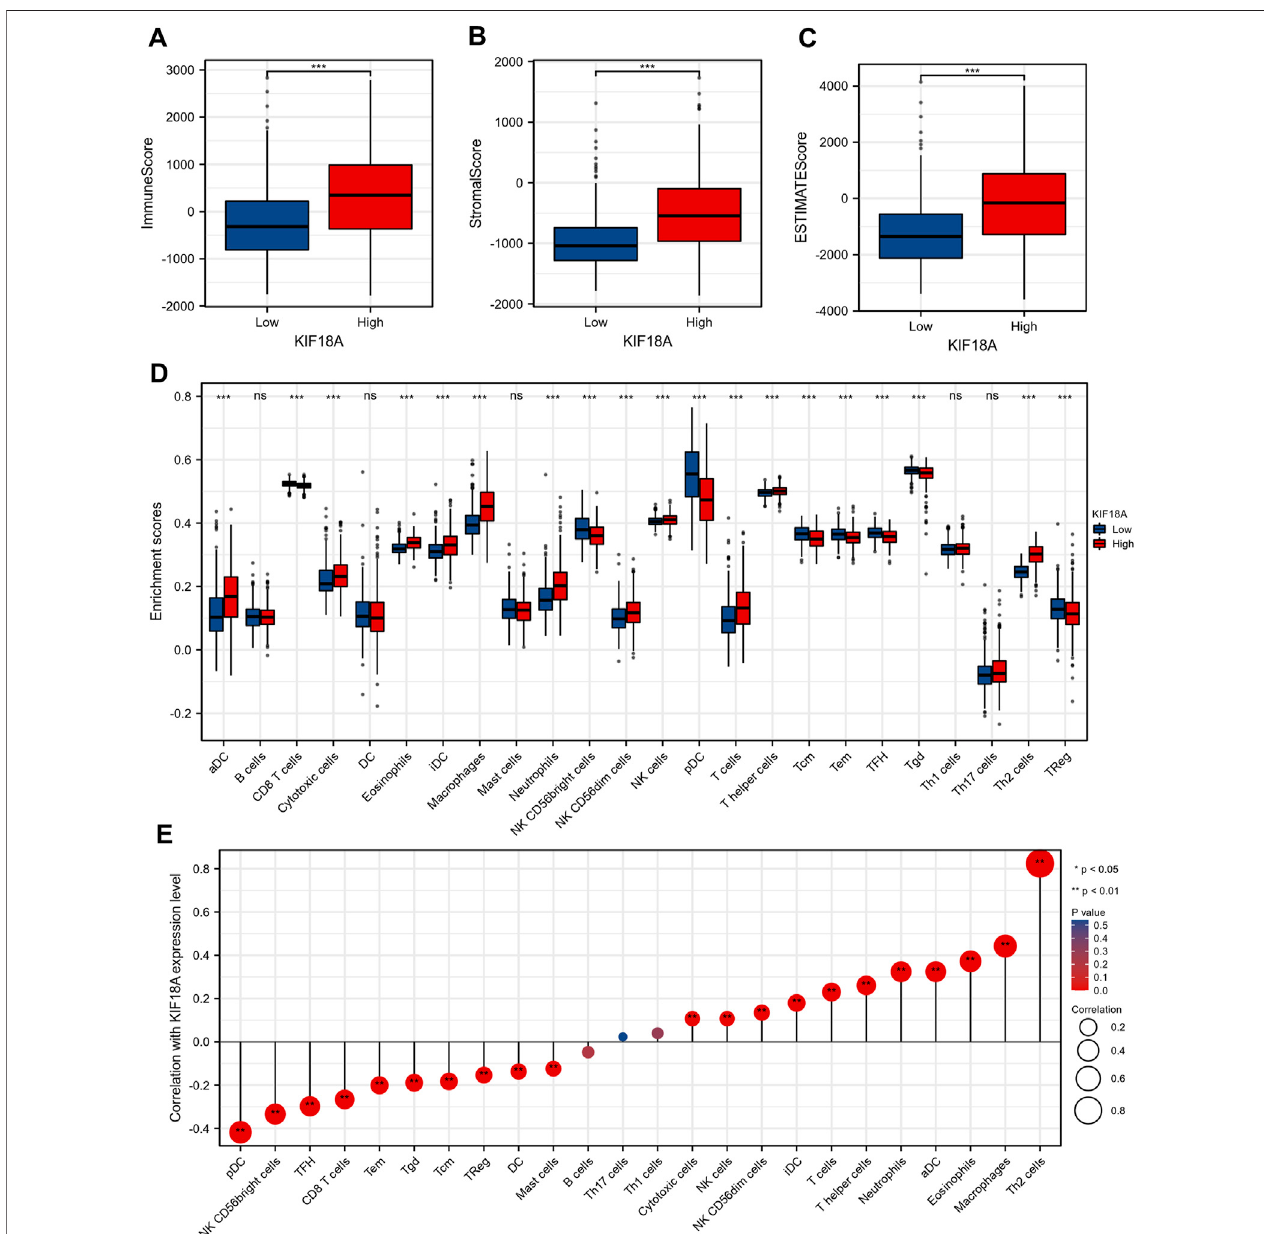
FIGURE 4 | The correlations between KIF18A mRNA expression level and immune cell in fi ltration. Comparison of Immune Score (A) , Stromal Score (B) and ESTIMATE Score (C) between the KIF18A-high and KIF18A-low patient groups. (D) The varied proportions of 24 subtypes of immune cells in high and low KIF18A expression groups. (E) The correlations between KIF18A mRNA expression level and the in fi ltration of different subtypes of immune cells. (ns, p ≥ 0.05; * p < 0.05, ** p < 0.01, *** p <